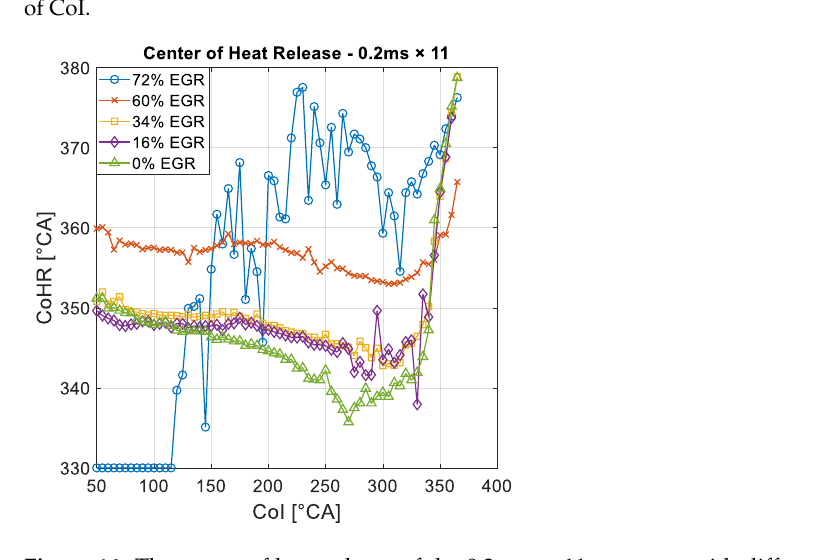
Figure 16. The center of heat release of the 0.2 ms × 11 structure with different EGR rates in the function of CoI.